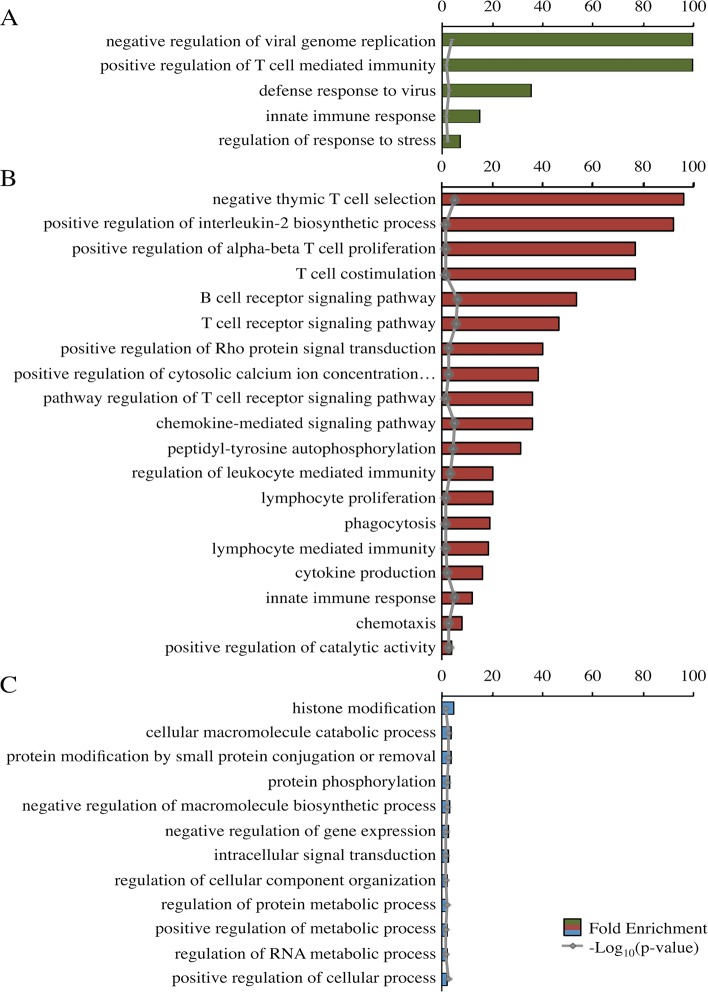
Fold enrichment of top-level overrepresented GO terms within modules of interest. Panther overrepresentation test using associated gene names for each of three modules: darkolivegreen module (A), darkred module (B), and steel blue module (C). Fold enrichment was capped at 100. −Log10(p value) shown in gray. All p values <0.05. Ellipses indicate those involved in phospholipase C-activating G-protein-coupled signaling.